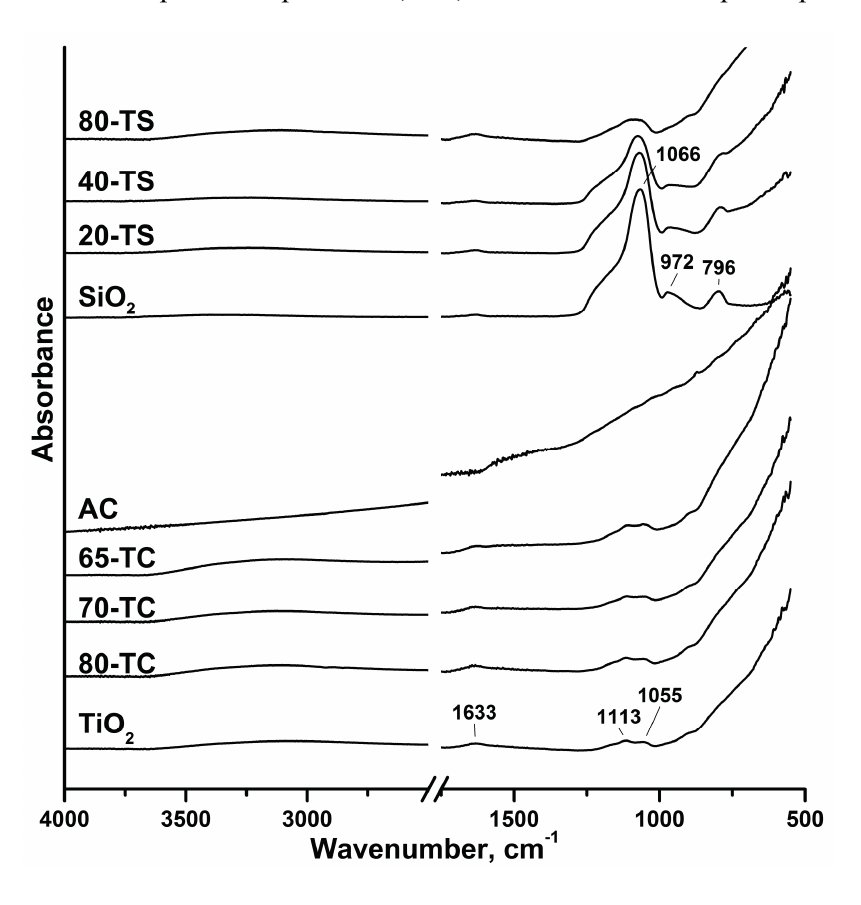
Figure 3. ATR FT - IR spectra for pure TiO 2 , AC, SiO 2 and for the composite